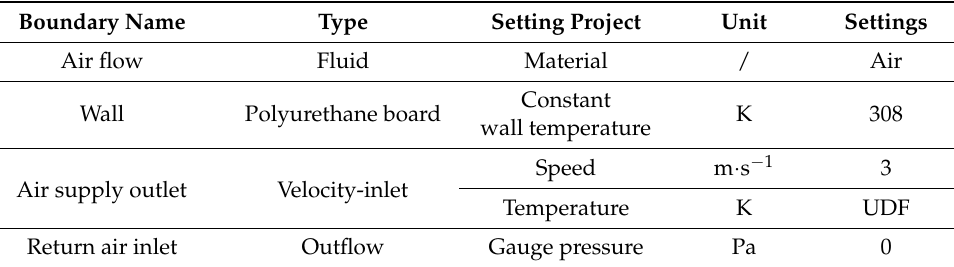
Table 3. Settings of the boundary